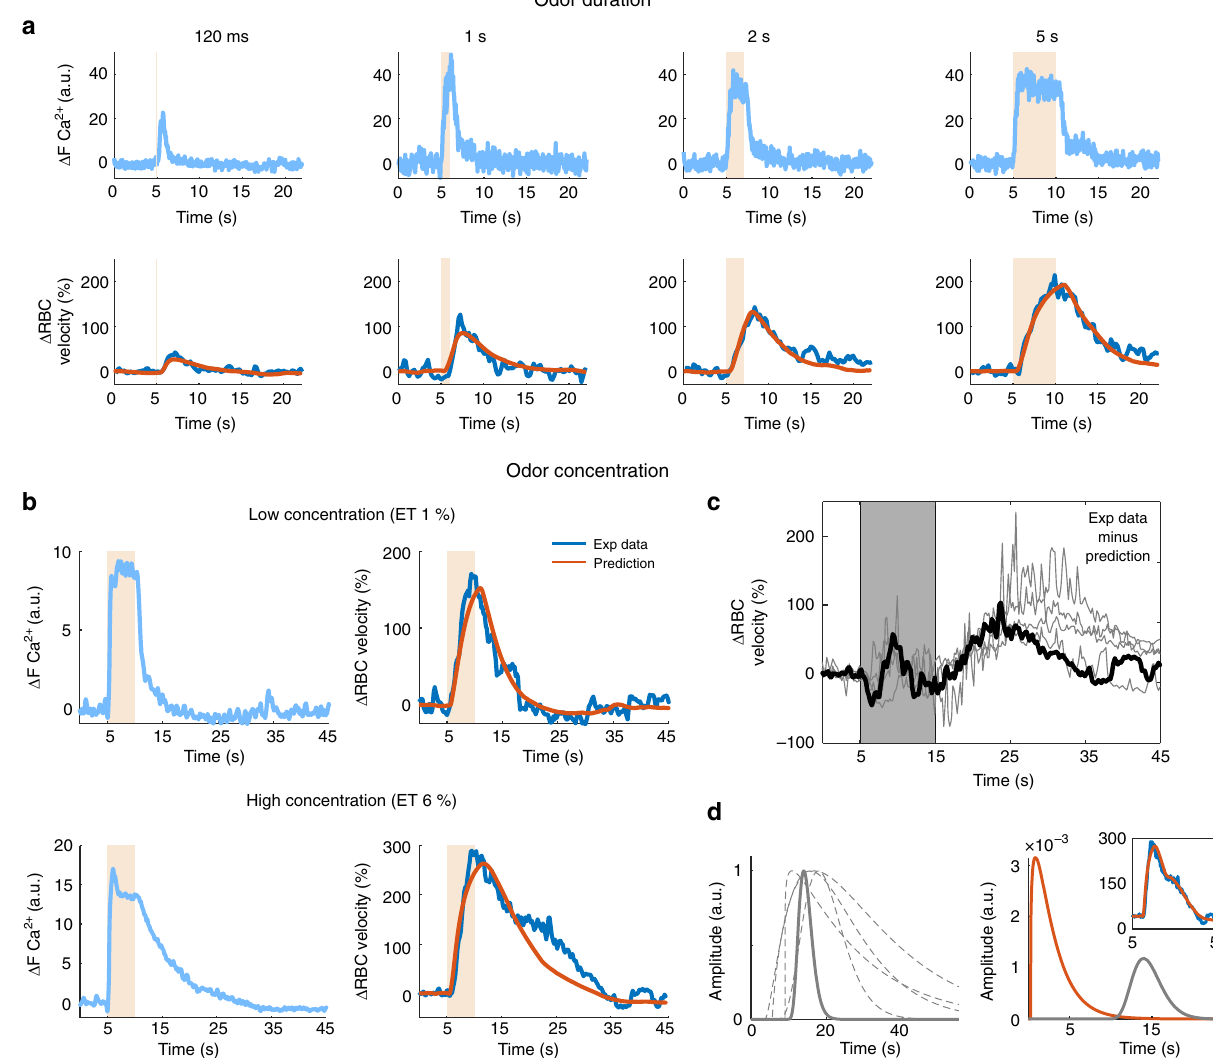
Fig. 2 Robustness of TFs with respect to stimulation duration and intensity. a Ca 2 + (top) and RBC velocity (bottom) responses to single sniff (120 ms), 1 s, 2 s, and 5 s odor stimulations. Using the standard μ TF (optimized with ET 1%, 5 s), vascular response predictions (orange traces) are robust for all durations. b Increasing the odor concentration from 1% (top traces, average of two trials) to 6% ET (bottom traces, average of three trials) reveals a delayed secondary vascular response, which is not correctly predicted (orange trace) with the standard TF (1% ET, 5 s). c Vascular responses after subtraction of their prediction using the standard TF ( n = 5 mice, data from b in black). Note that trace fl uctuations between 5 and 15 s (gray background) result from slight differences of onset, slope, and response peak between real and predicted responses. The second vascular component is clearly delayed by ∼ 10 s. d Left, novel TFs optimized on vascular responses after subtraction (the thick trace is the TF from the data in b and c ). Note the heterogeneity in peak jitter and shape. Right, combination of the two μ TFs (standard μ TF in orange, second component μ TF in gray) can predict correctly the entire vascular response (see inset, same trace as in b ) after adjustment of their corresponding